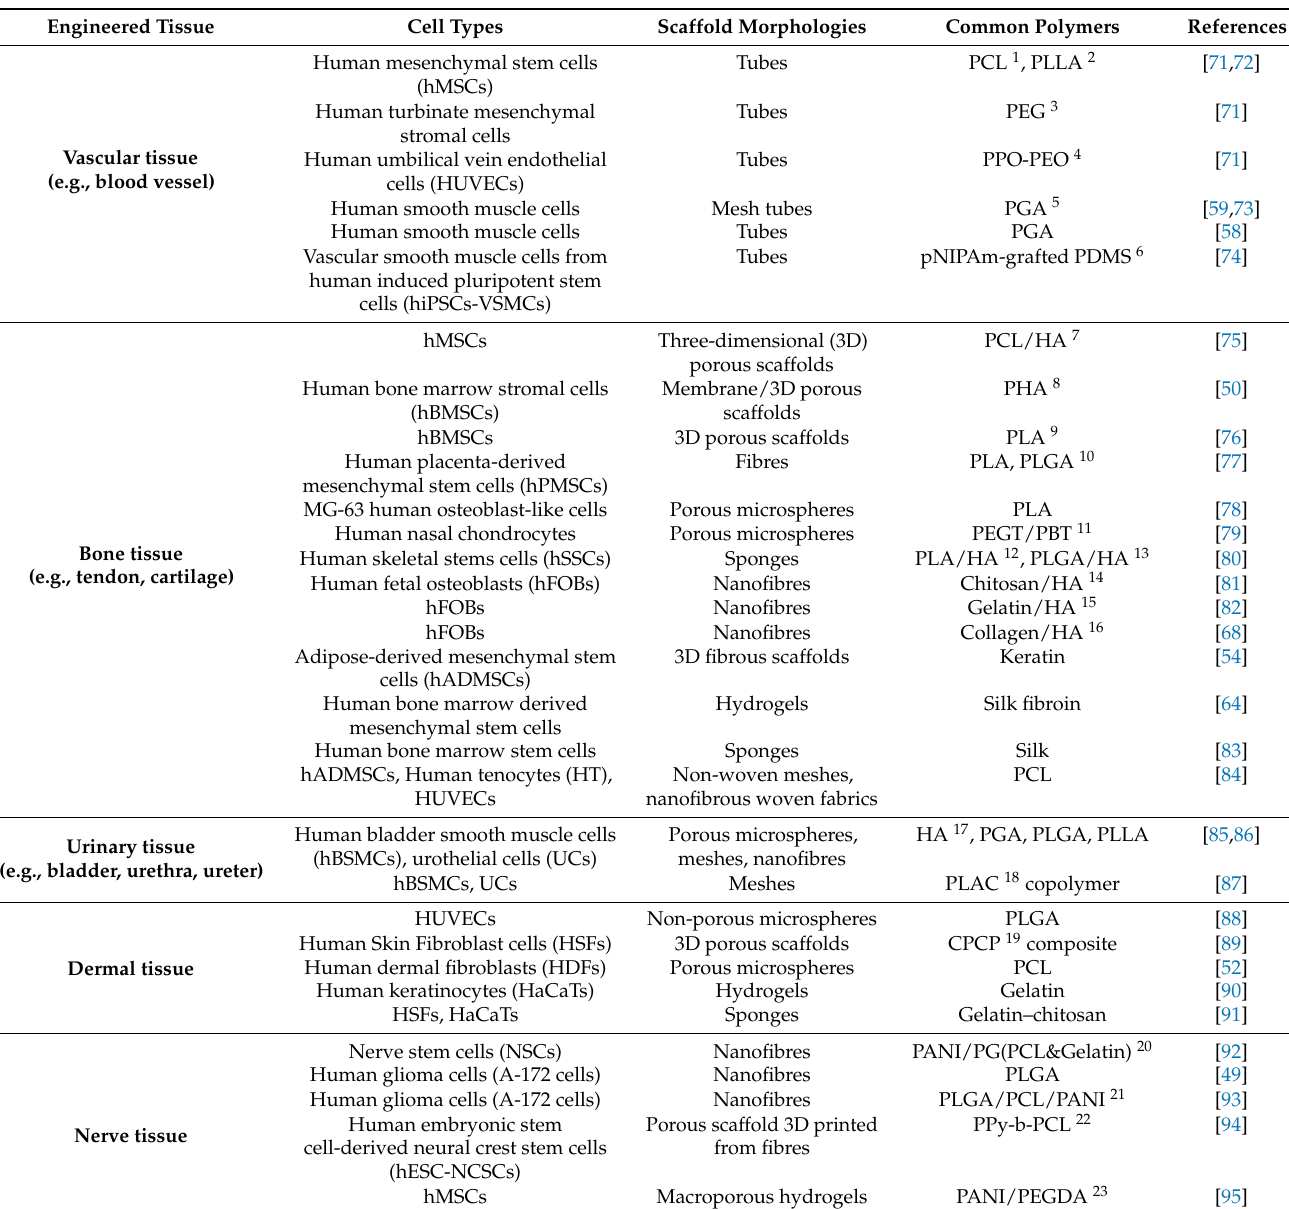
Table 1. Summary of the commonly used polymeric scaffolds with varying morphologies and respective cell types for the engineering of different human target